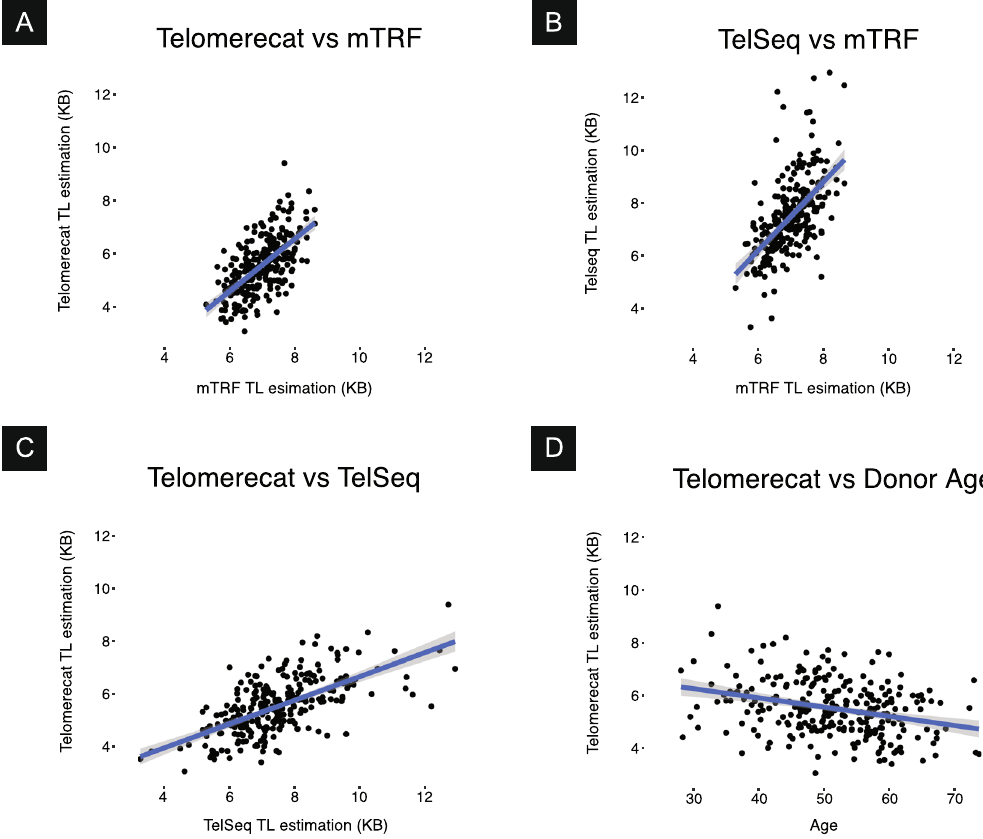
Figure 1. Scatter plots describing the relationship between Telomerecat, mTRF, and TelSeq estimates of telomere length